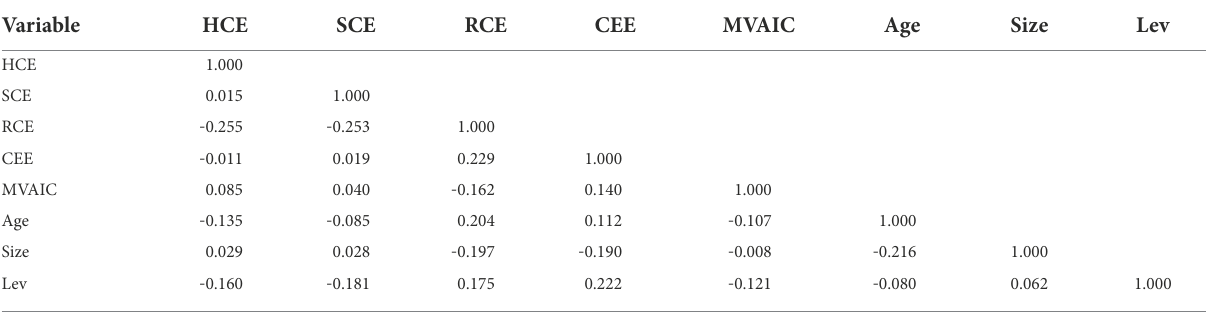
Table 3 Correlation analysis of Pakistani